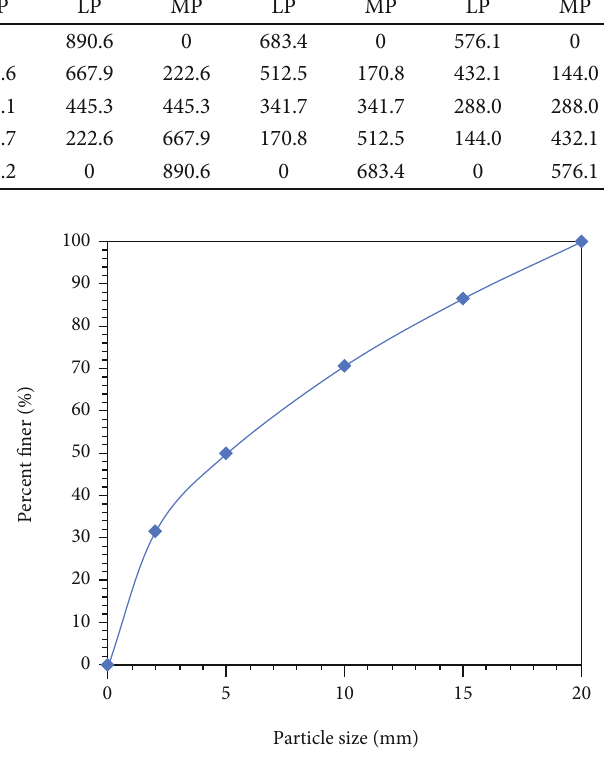
Figure 1: The diagram of limestone and mudstone mixture in no. 4 normal fault of Buliangou mine. Table 1: Mixing scheme of LP and MP for di ff erent samples (LP: limestone particles; MP: mudstone particles). Sample no.